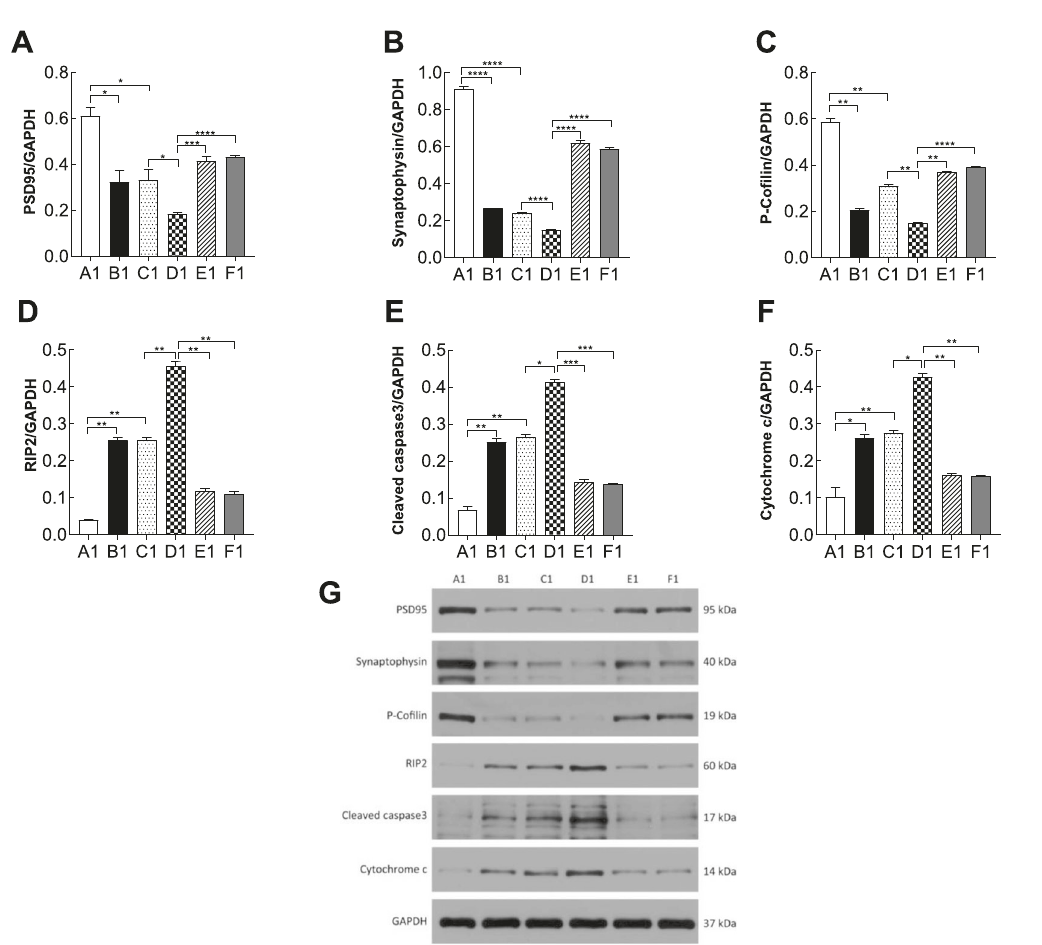
Fig. 7 Statistical analysis of western blot pro fi les in prefrontal cortical neurons ( n = 3). A PSD95. B Synaptophysin. C P-co fi lin. D RIP2. E Cleaved caspase-3. F Cytochrome c. G PSD95, synaptophysin, P-co fi lin, RIP2, cleaved caspase-3, cytochrome c /GAPGH expression levels in prefrontal cortical neuronal cells were detected using western blotting. Synaptic-related proteins and apoptosis-related proteins were upregulated in the stroke, depression and PSD groups, and knock down of p75NTR and JNK1 in PSD models reversed this effect. “ * ” on the top of each bar represents the P value compared to the control group. Error bars represent the mean ± SD. * P < 0.05, ** P < 0.01, *** P < 0.001, **** P < 0.0001. Con control, OGD oxygen-glucose deprivation, CS corticosterone. A1: Con; B1: OGD; C1: CS; D1: OGD + CS; E1: OGD + CS +